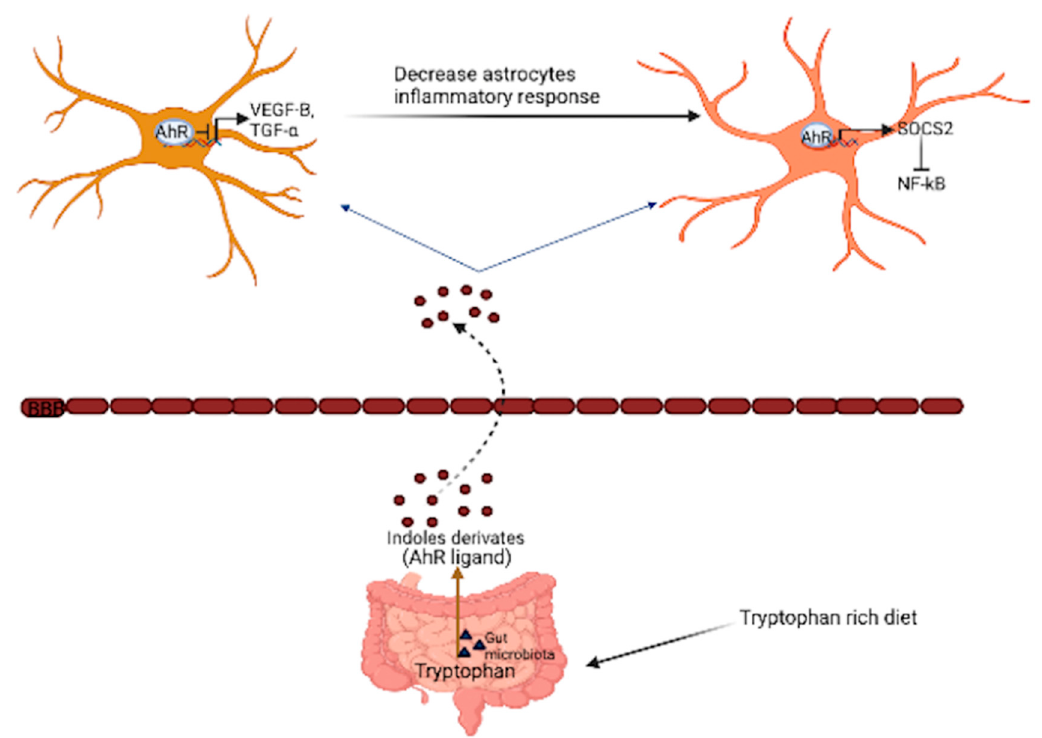
Figure 3. Suppression of CNS inflammation in glial cells through the activation of AhR by gut microbiota derivatives. Tryptophan metabolites, such as indole derivatives derived from the gut microbiota, influence CNS inflammation through the suppression of vascular endothelial growth factor B (VEGF-B) and TGF-alpha (transforming growth factor-alpha) in microglia cells. AhR activation by these metabolites also directly signals to SOCS2 protein (NF- κ B inhibitor) in astrocytes.